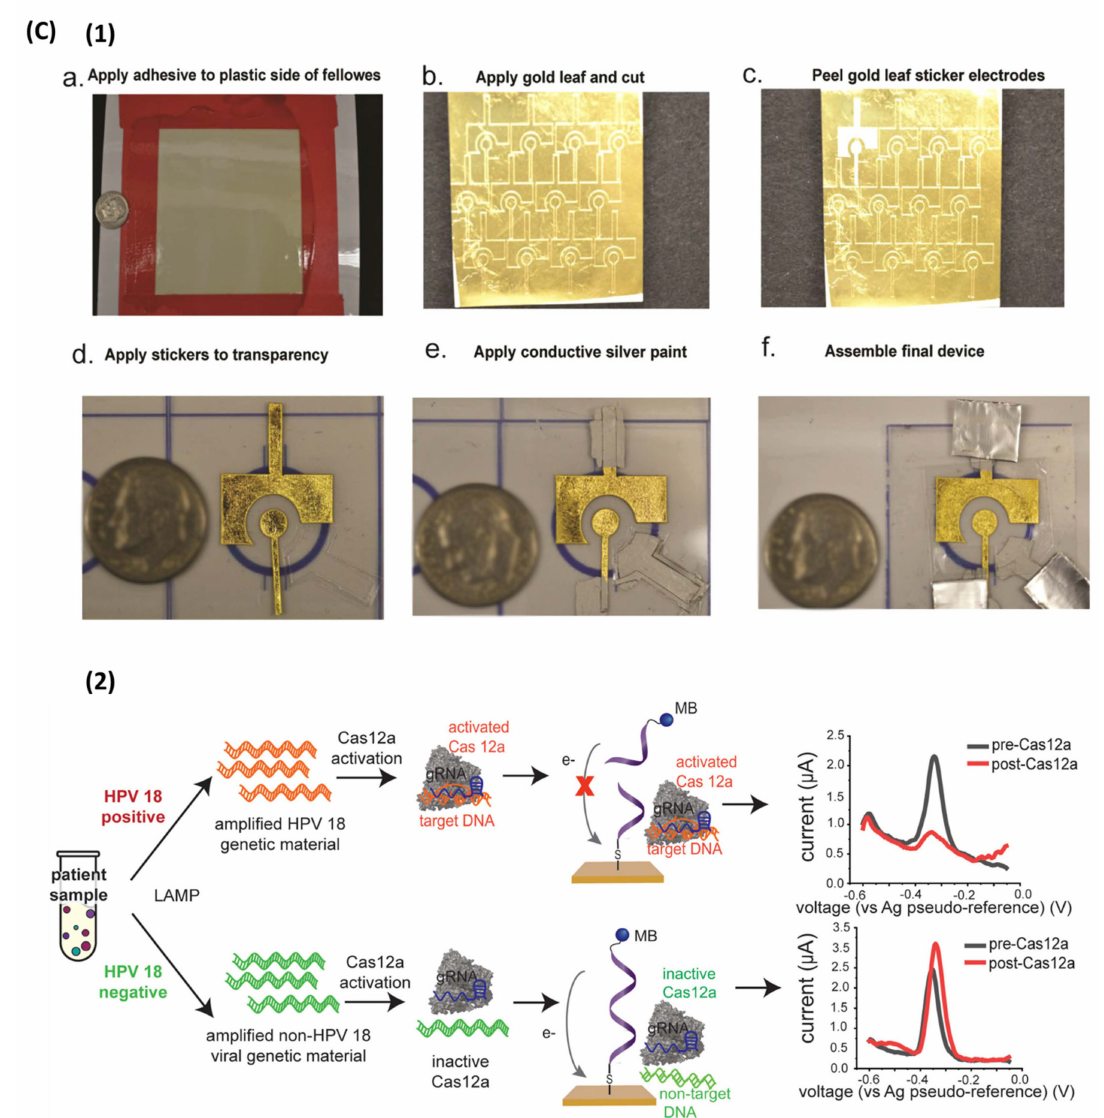
Figure 3. LAMP − based electrochemical sensors. ( A ) LAMP amplicon detection on a screen-printed graphene electrode (SPGE) using a portable potentiostat device. ( B ) Schematic illustration of LAMP E-sensor for detection of Group B Streptococci . ( C ) ( C1 ) Gold-leaf electrode’s fabrication; ( C2 ) Working principle of CRISPR/Cas12a activation-based sensor for detection of the HPV virus. Reproduced with permission from references [75,77,78]. Copyright 2020 Elsevier, 2021 American Chemical